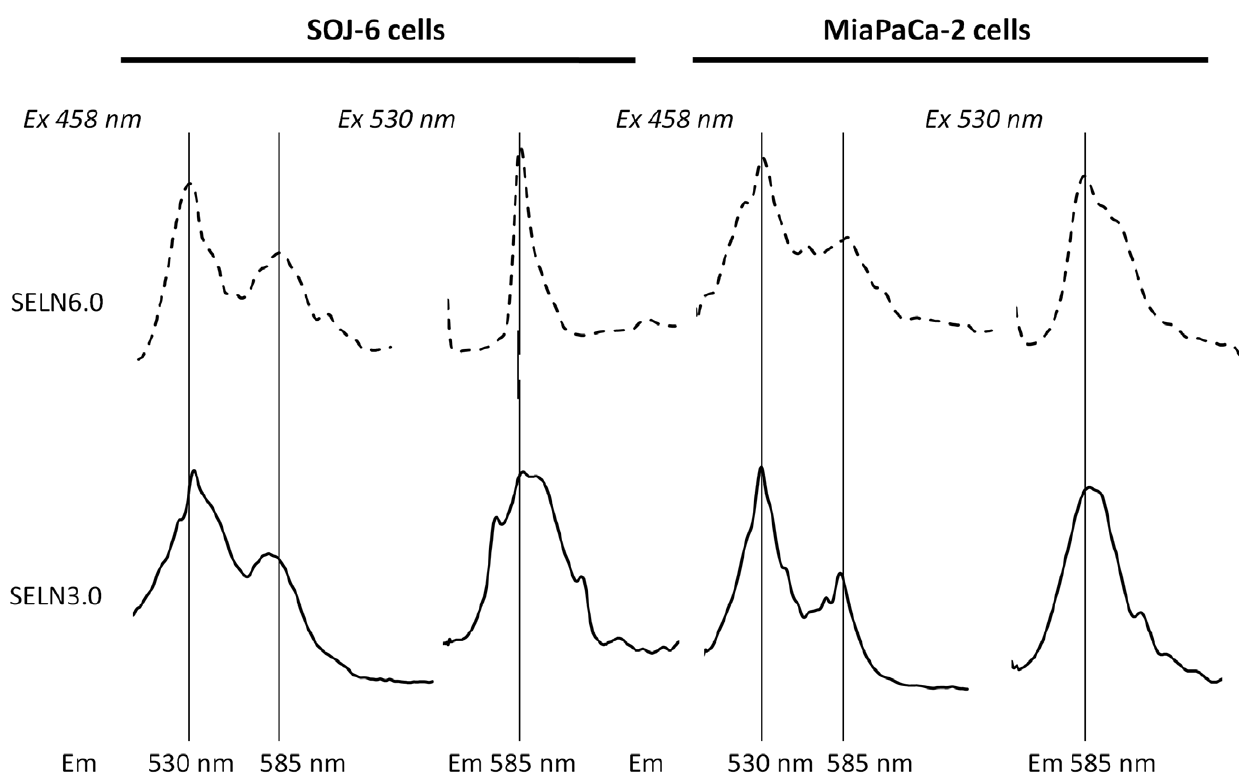
Figure 9. Cell fluorescence upon incubation with fluorescent SELN. SOJ-6 and MiaPaCa-2 cells (0.5 6 10 6 cells) were suspended in 2 ml (final volume) of PBS and incubated for 90 min (25 u C) with 50 m l SELN3.0 and SELN6.0 (4 nmoles cholesterol/ml). Cells were then pelleted and washed with PBS (twice) and finally suspended in 2 ml PBS before fluorescence analysis after excitation at 458 nm (left peaks) or at 530 nm (right peaks). The self- fluorescence of cells was subtracted from given